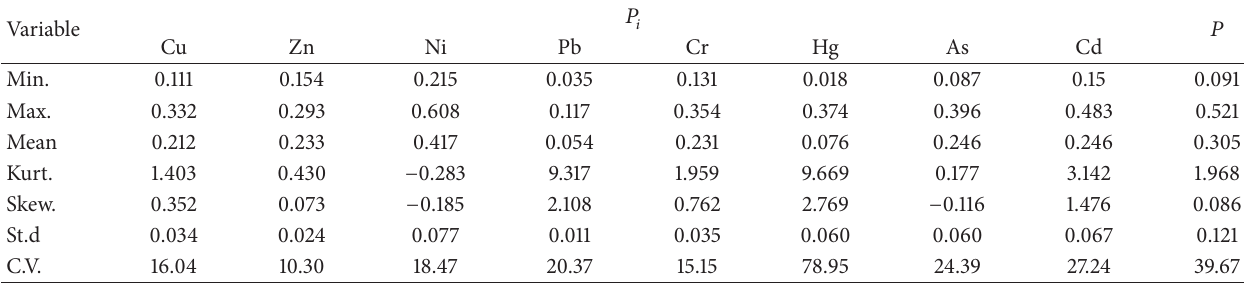
Table 3: Descriptive statistics of soil heavy metals pollution indices.